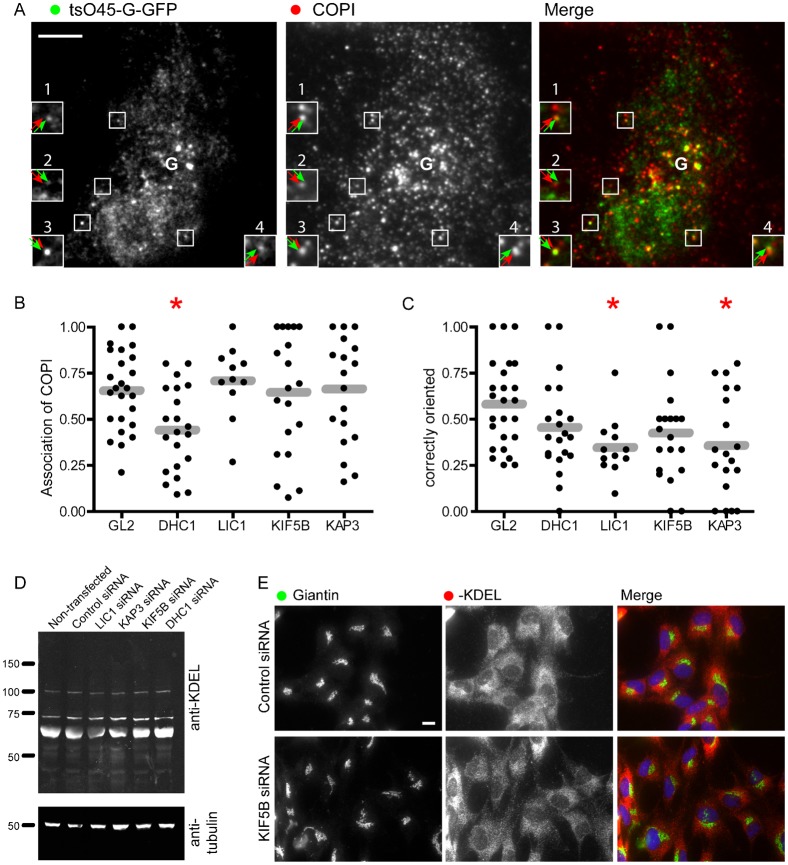
Motor subunit depleted cells expressing tsO45-G-GFP were fixed and immunolabelled to detect COPI (β′-COP).(A) An example of a control (GL2 siRNA transfected) cell. (B,C) Image quantification was performed manually to determine (B) the number of tsO45-G-GFP puncta with associated COPI labelling and (C) the polarity of these structures with respect to the Golgi apparatus. “Correctly oriented” structures are those with the COPI-positive domain facing away from the Golgi and the tsO45-G-GFP-positive domain facing towards the Golgi. “G” indicates the user-defined point of the Golgi apparatus. Asterisks in panels B and C dictate those cases for which a statistically detectable difference was found using ANOVA with Dunnett's post-hoc test. (D) RPE1 cells were transfected with siRNA against the various motor proteins for 72 hours. The cells were then lysed and after a protein assay equal amounts of protein analyzed by immunoblotting with an anti-KDEL or an anti-α-tubulin antibody. (E) Immunofluorescence labelling of control or KIF5B depleted cells with antibodies directed against giantin or KDEL bearing proteins. Scale bars: 10 µm (A,E).